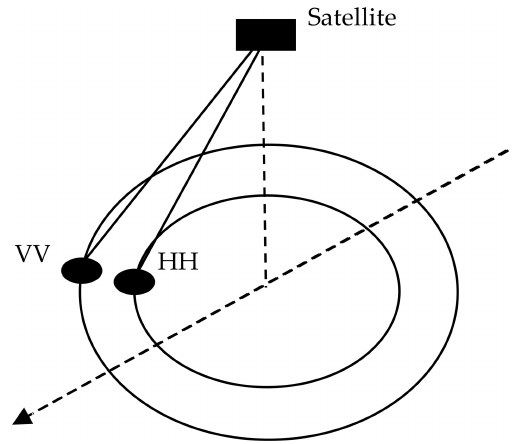
Figure 2. Rotating pencil-beam scatterometer. Table 3. Main parameters of QuikSCAT